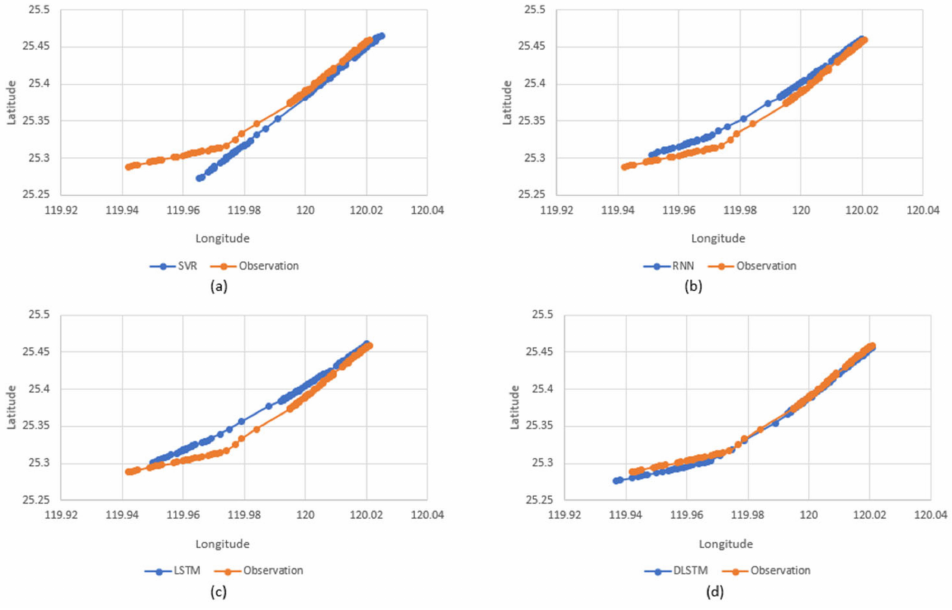
Figure 10. Models predicted result in vessel 413484000. ( a ) SVR, ( b ) RNN, ( c ) LSTM, ( d )